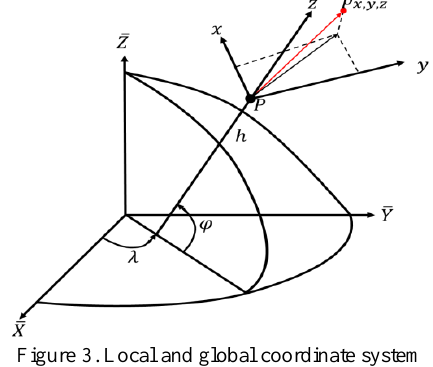
Figure 3. Local and global coordinate